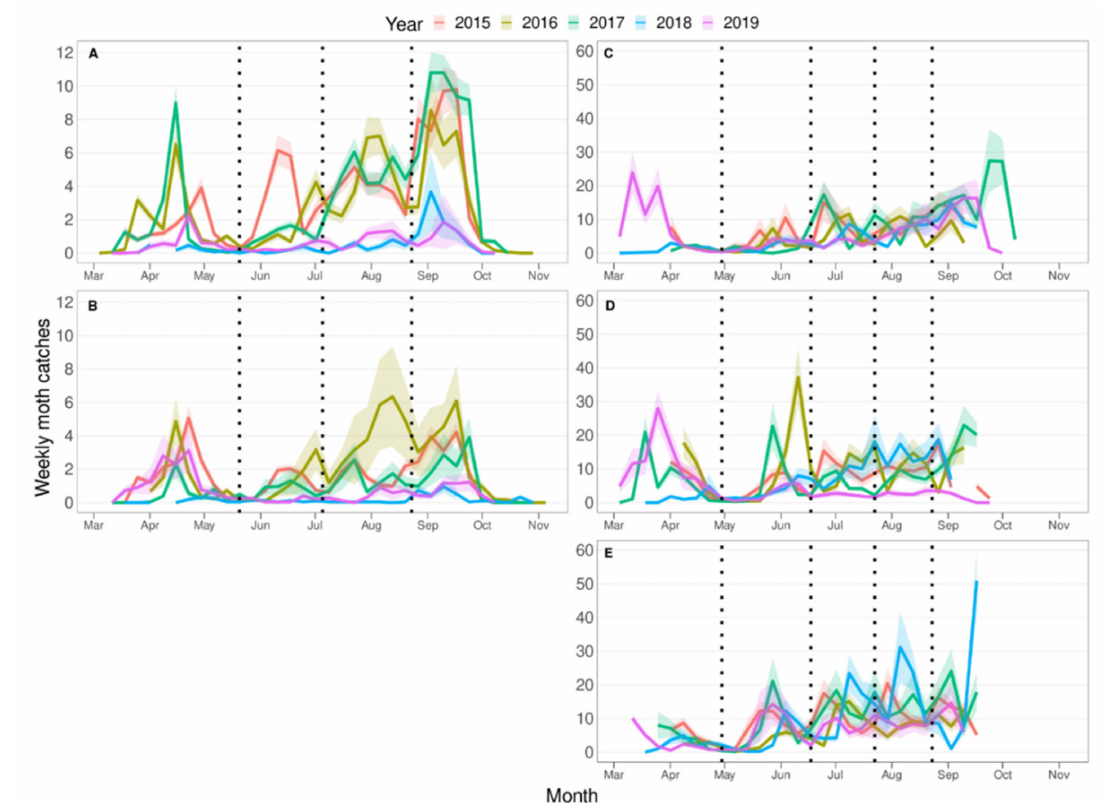
Figure 2. Weekly moth catches (mean ± SE) for each year (2015–2019) and for each area. ( A ) Alt Empord à and ( B ) Baix Empord à , both of Girona province; and ( C ) Stone area, ( D ) Mixed area, and ( E ) Pome area, the three of Lleida province. Dotted vertical lines indicate the approximate minima between flights. Shades of each line indicates the SE. Note: the y -axis scale is different for AB than for